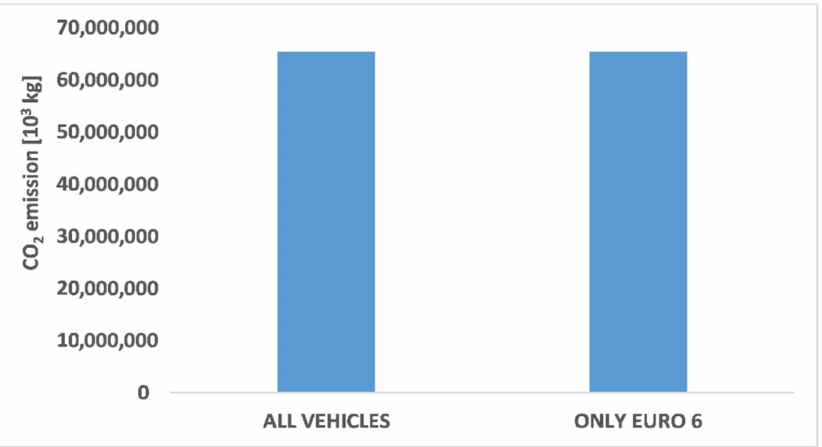
Figure 16. Comparison of CO 2 emissions from all vehicles and Euro 6 vehicles only.